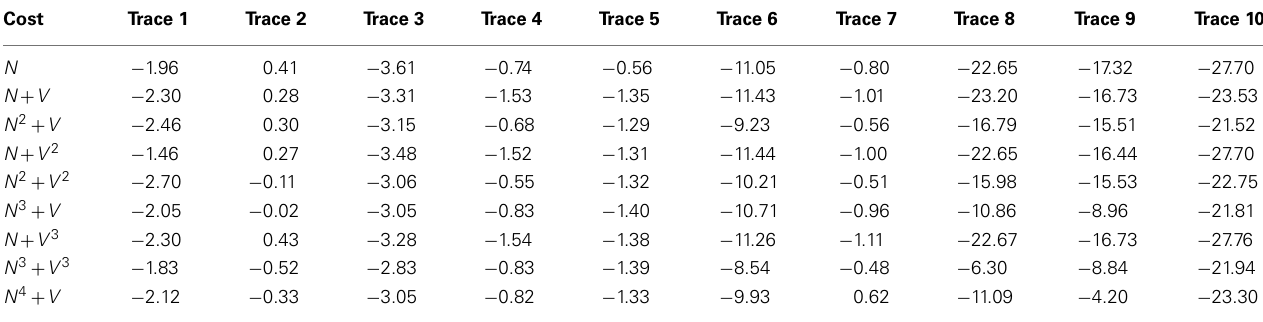
Table 7 |The percentage length errors over the benchmarks as a result of varying the cost function associated with the routing algorithm. Cost Trace